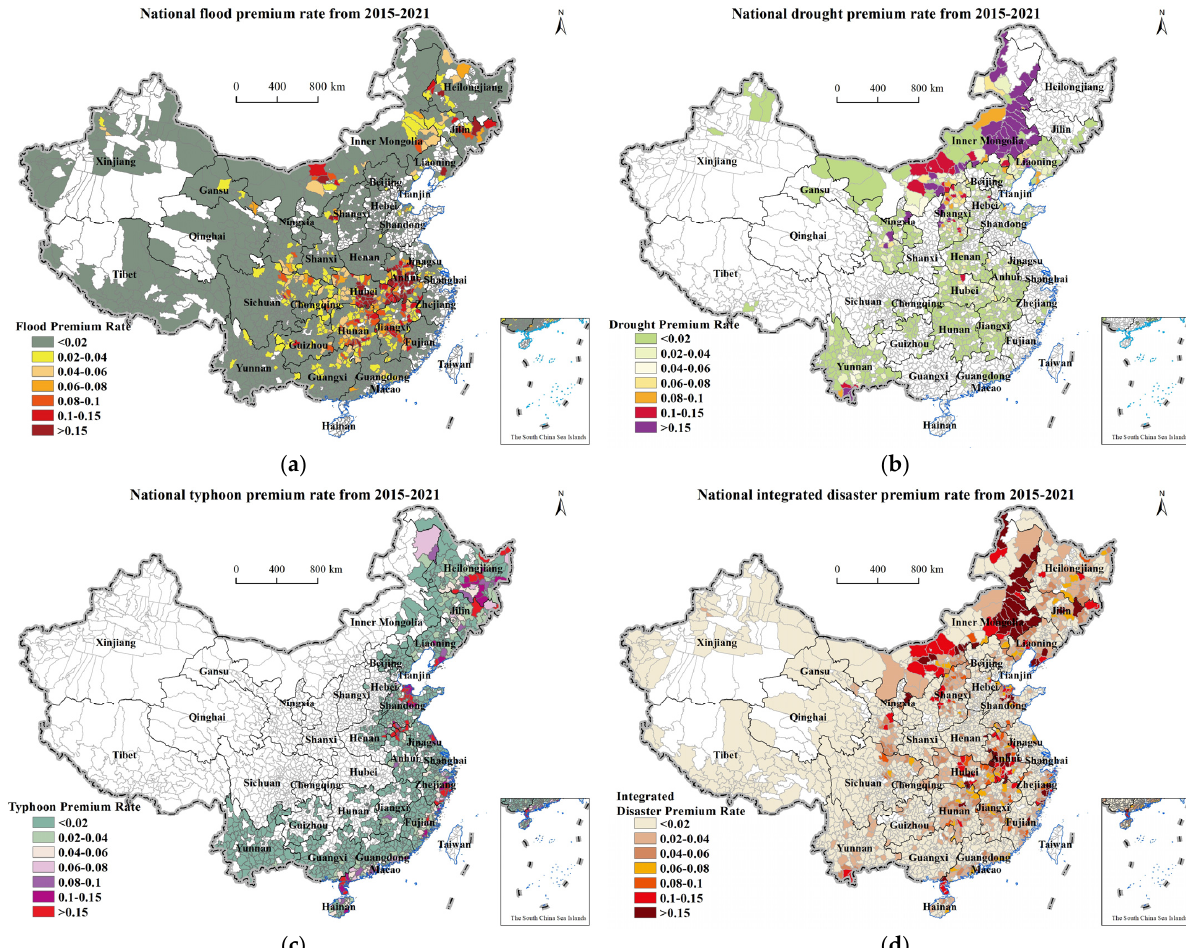
Figure 6. National flood ( a ), drought ( b ), typhoon ( c ), and integrated disaster ( d ) premium